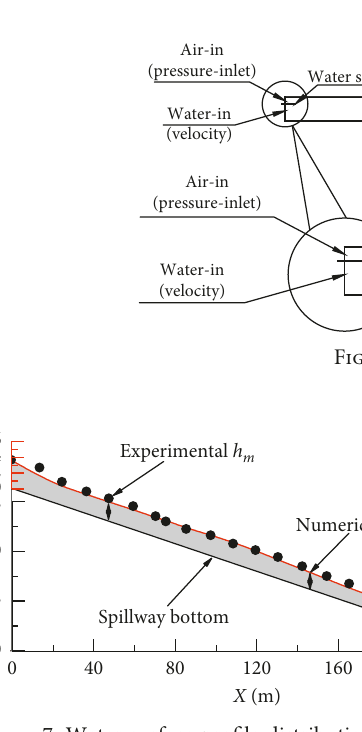
Figure 7: Water surface profile distribution in central axis.